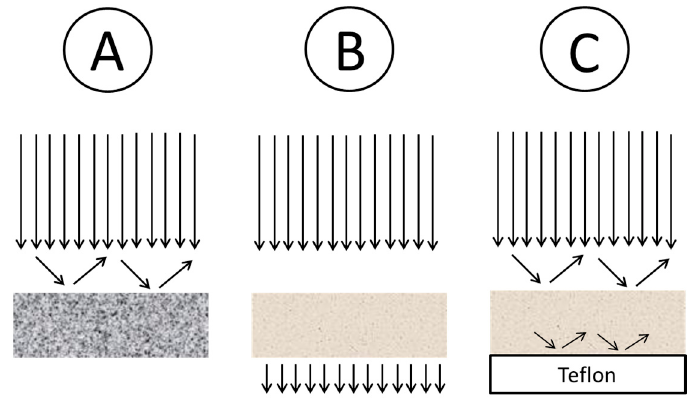
Figure 1. Measurement principles of ( A ) diffuse reflection, ( B ) transmission and ( C ) transflection mode.